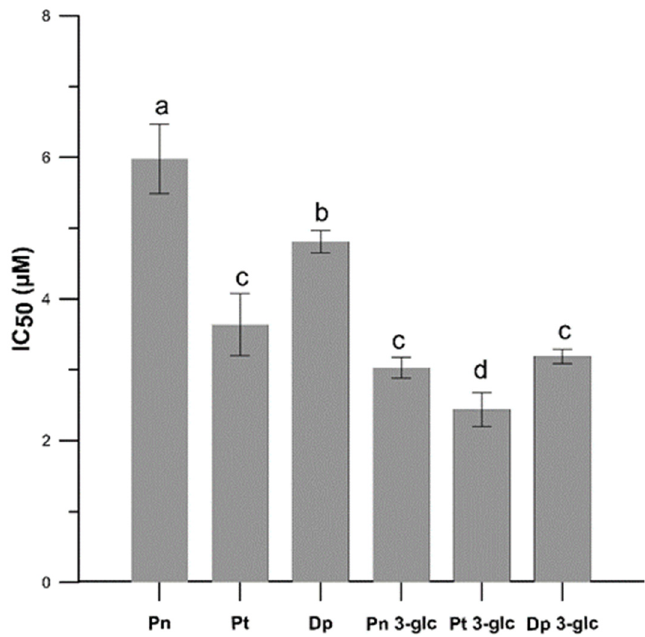
Figure 2. The antioxidant activity (IC 50 ) for Pn, Pt, Dp, Pn 3-glc, Pt 3-glc and Dp 3-glc into lipid mimic membrane. Membrane oxidation was induced with AAPH ● compound. IC 50 values are the membrane. Membrane oxidation was induced with AAPH • compound. IC 50 values are the averages averages of three independent measurements ± SD. Different letters (a – d) indicate significant of three independent measurements ± SD. Different letters (a–d) indicate significant differences differences ( p < 0.05). ( p <